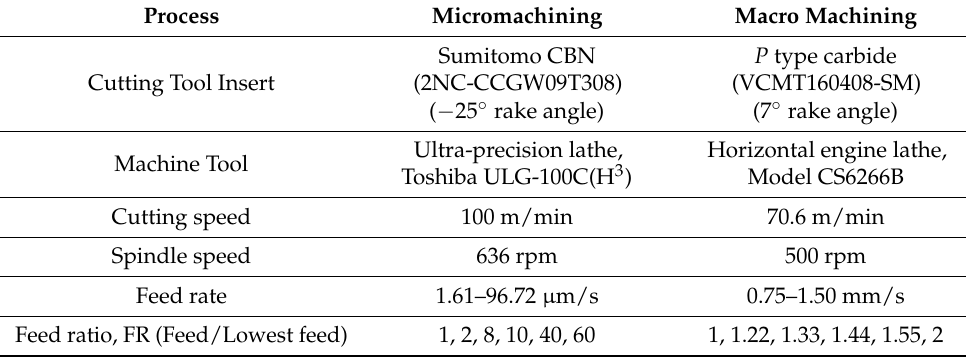
Table 1. Cutting Tool, Machine Tool, Machining